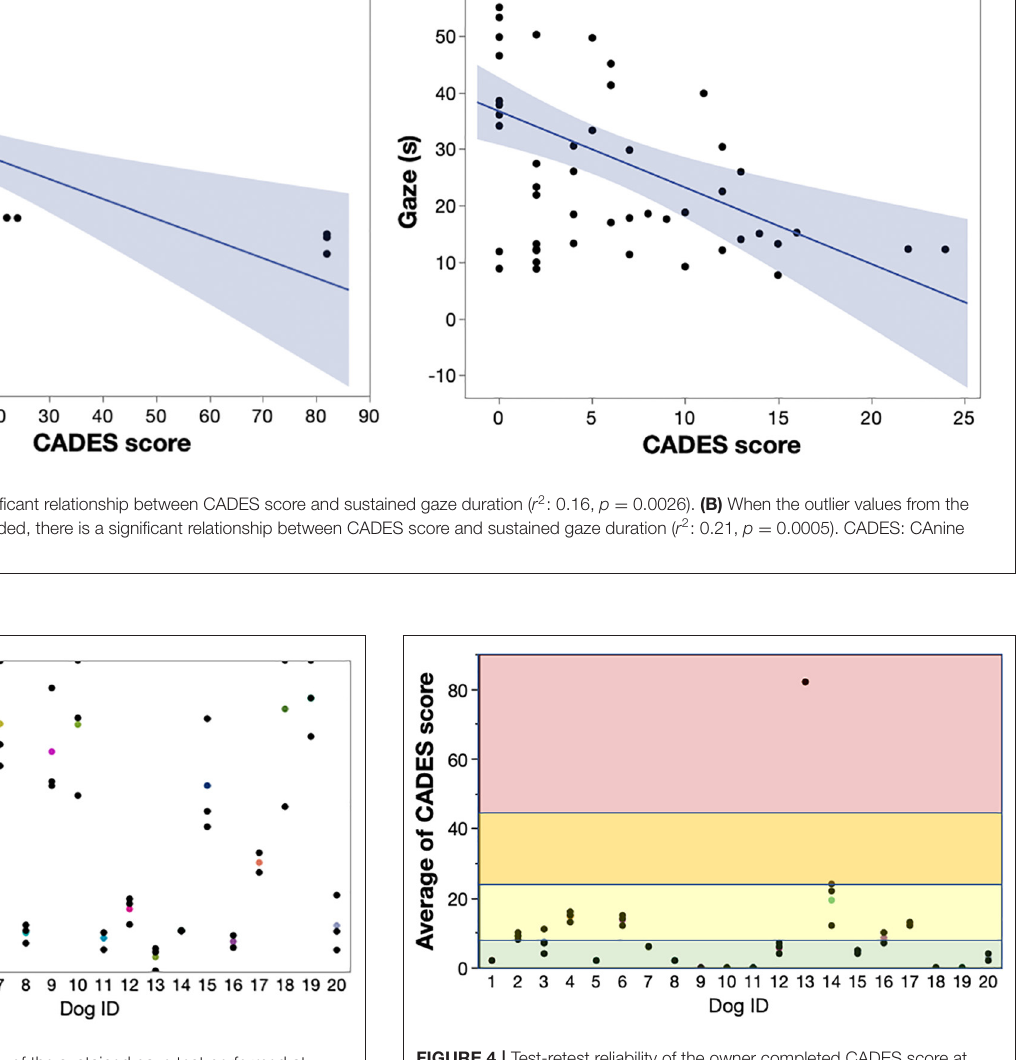
FIGURE 3 | Test-retest reliability of the sustained gaze test performed at weekly intervals for 3 weeks. The colored points are the mean gaze duration for each dog and the black points are the mean gaze durations for each of the 3 week testing points. ICC: 0.85. ICC: Intraclass Correlation Coefficient; s: seconds.